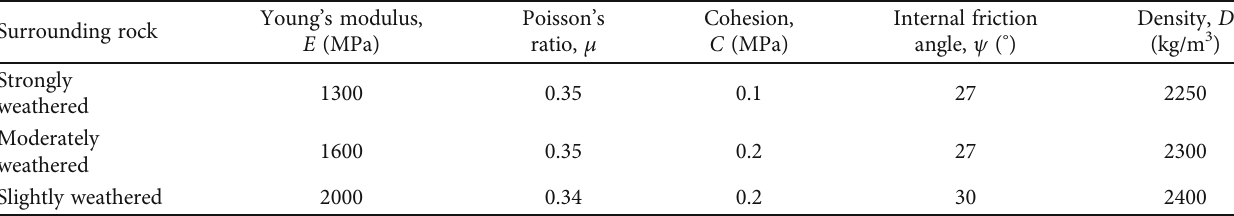
Figure 10: Tunnel bench excavation model. Table 2: Mechanical parameters of granite.